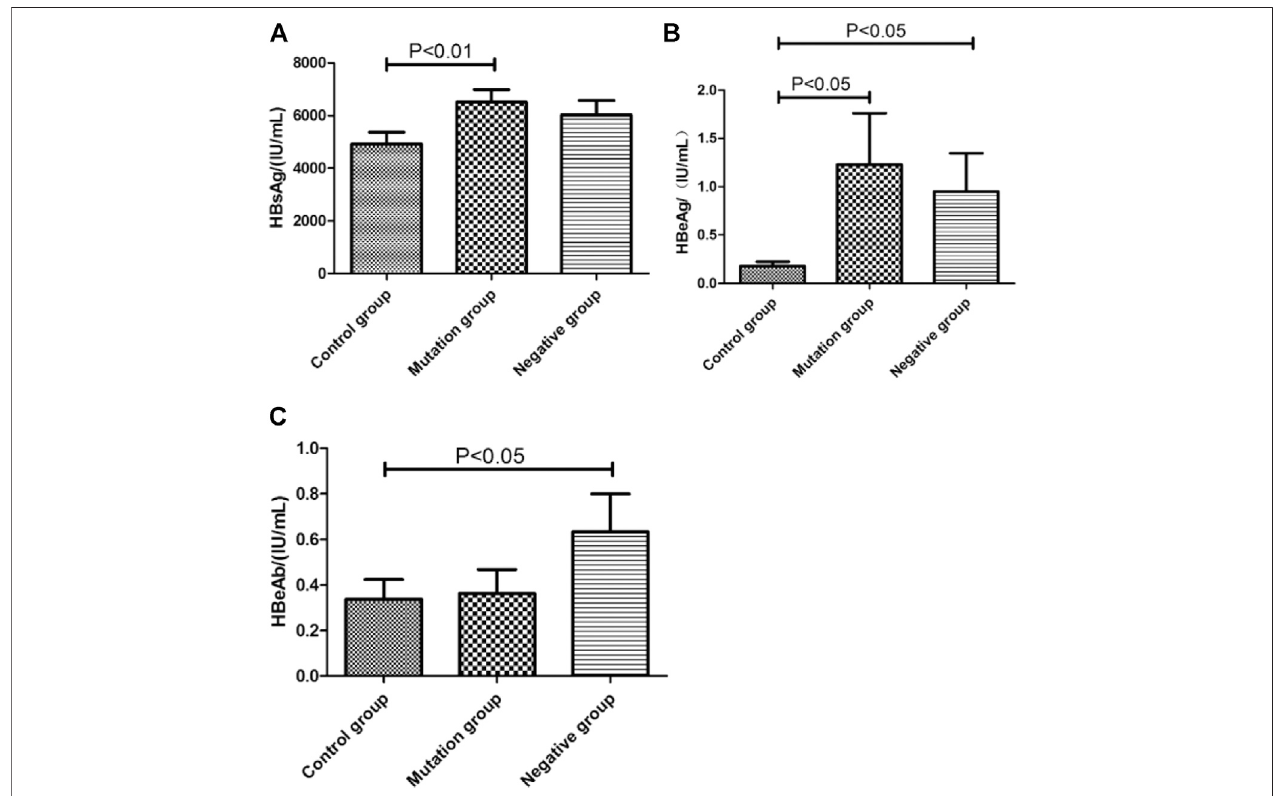
FIGURE4| ThevirologicalofHBVmarkslevelindifferentYMDDmutationalmotifandcontrolgroups. (A – C) :DistributionofHbsAg (A) ,HbeAg (B) ,HbeAb (C) titersin control group, mutation group and negative group, respectively.